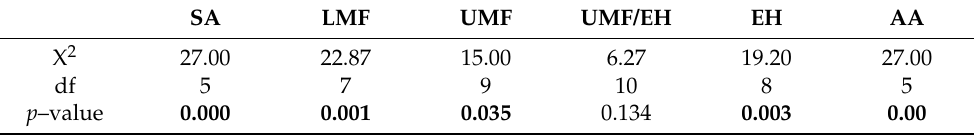
Table 2. Chi–squared (X 2 ) statistical results of species composition in each sites.